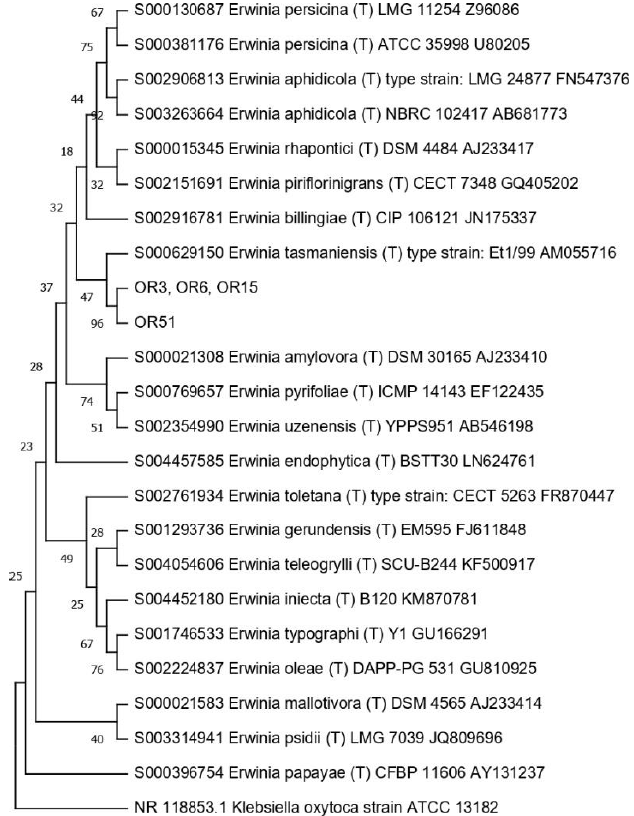
Figure 4. Phylogenetic tree for the genus Erwinia.